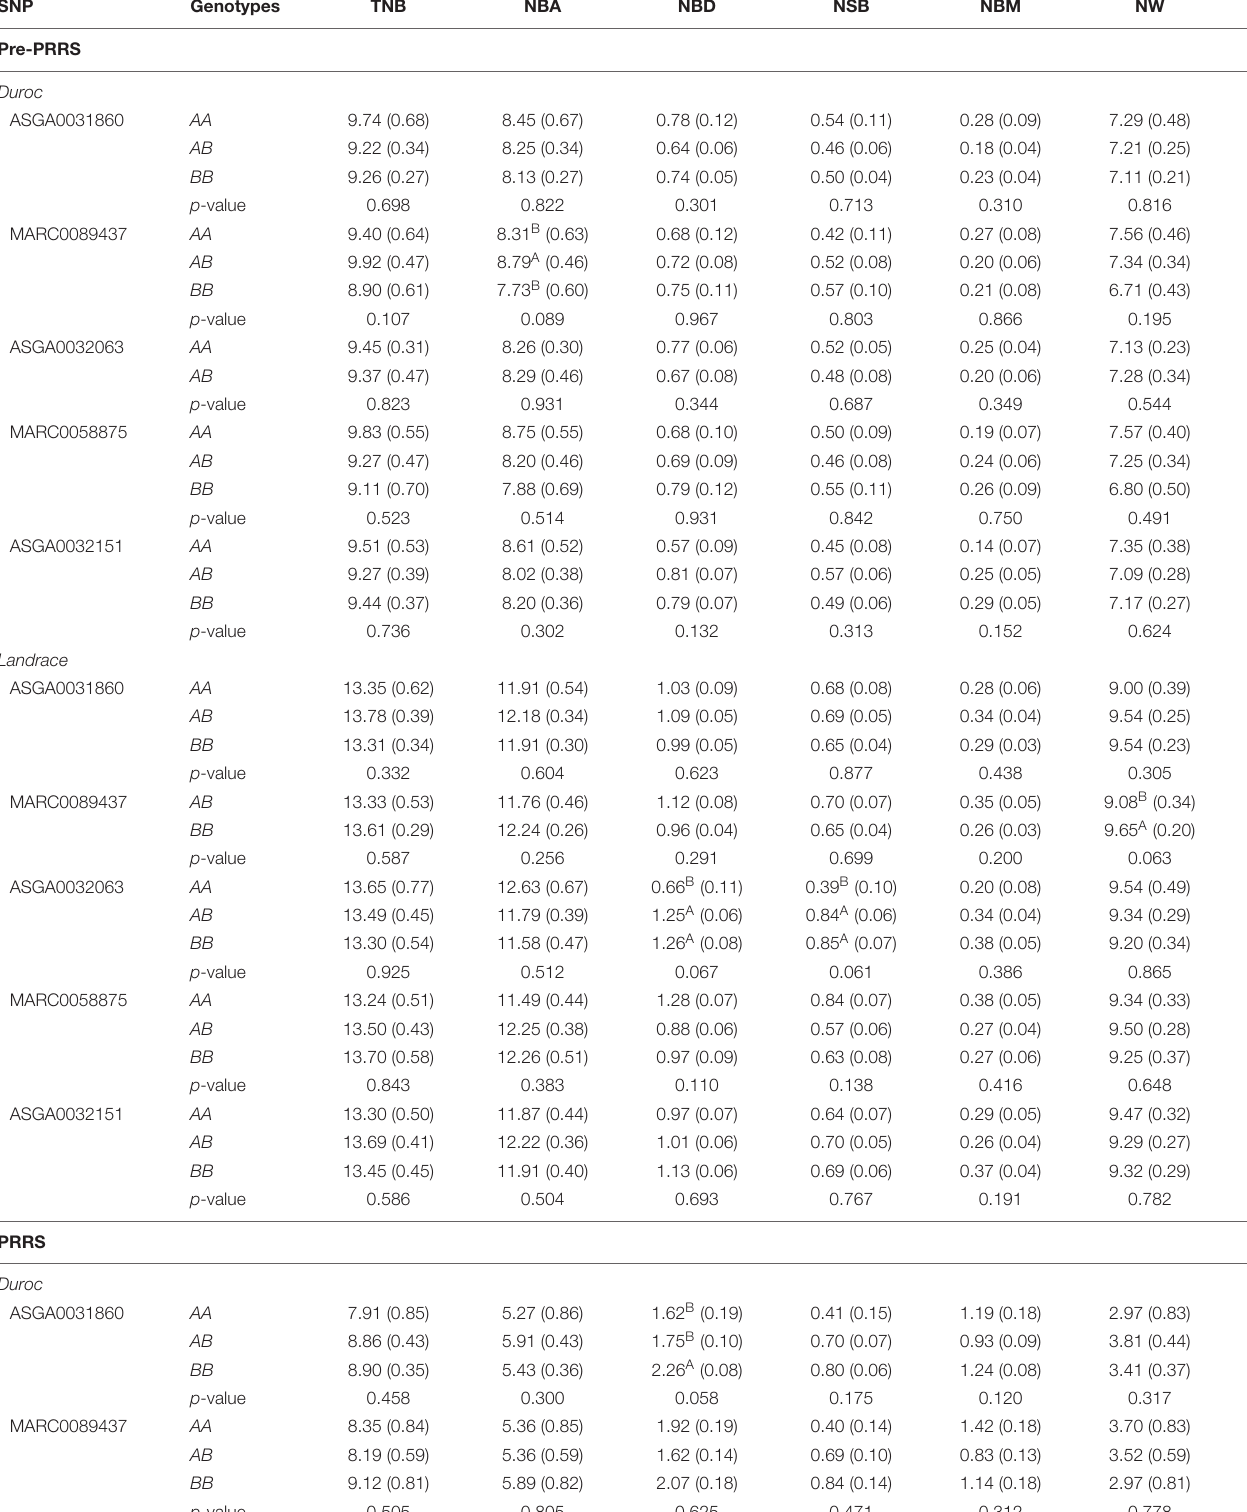
TABLE 3 | Effect 1 of selected SNPs 2 associated with sample-to-positive (S/P) ratio on reproductive traits 3 across PRRS phases. SNP